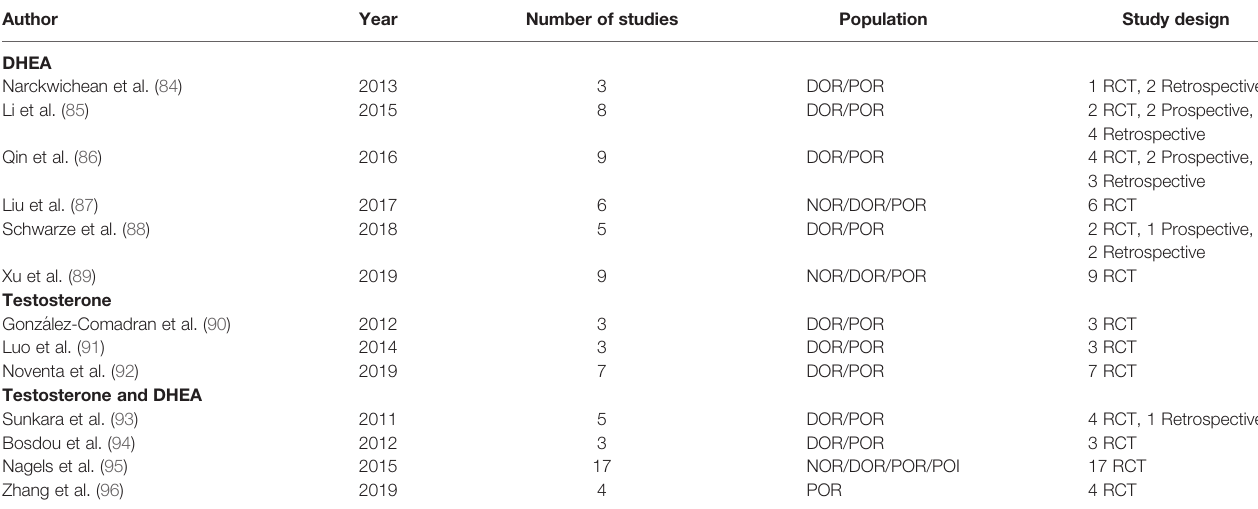
TABLE 3 | Published meta-analysis on the use of DHEA and Testosterone in